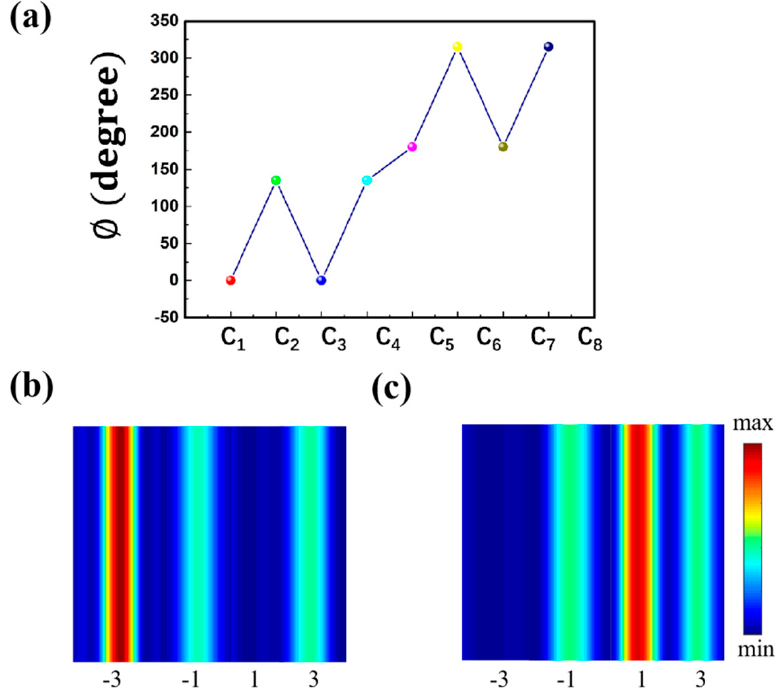
− H V component are shown.